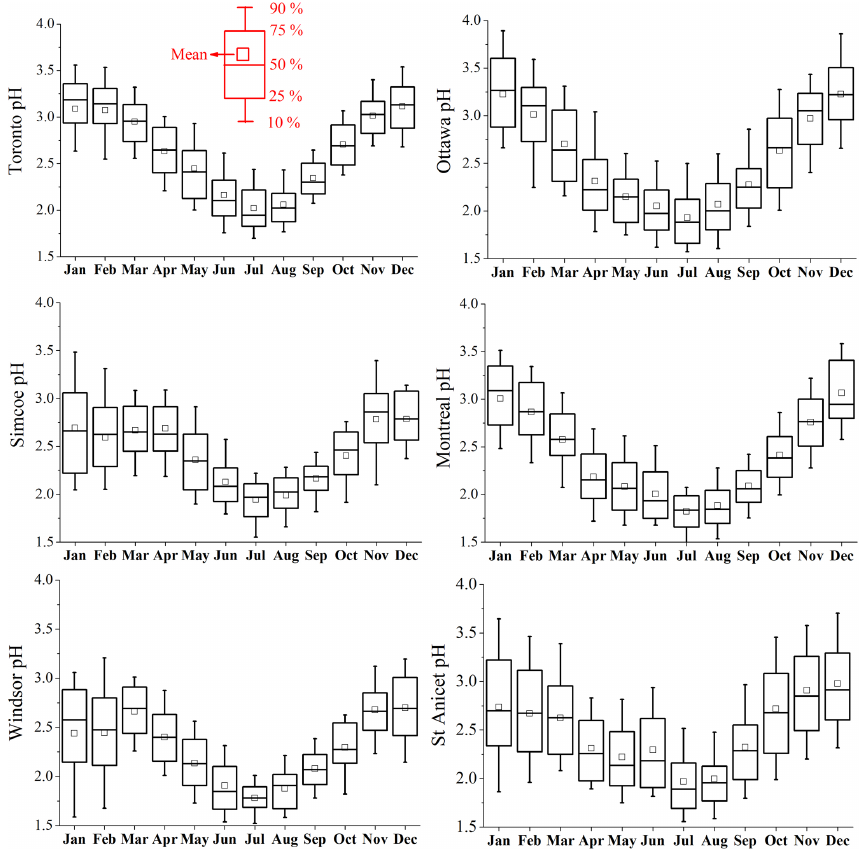
Figure 3. The box-and-whisker plot of aerosol pH in each month at six sites. In each box, the top, middle and bottom lines represent the 75th, 50th and 25th percentiles of statistical data, the upper and lower whiskers represent 90th and 10th percentiles, and the square marks represent the mean